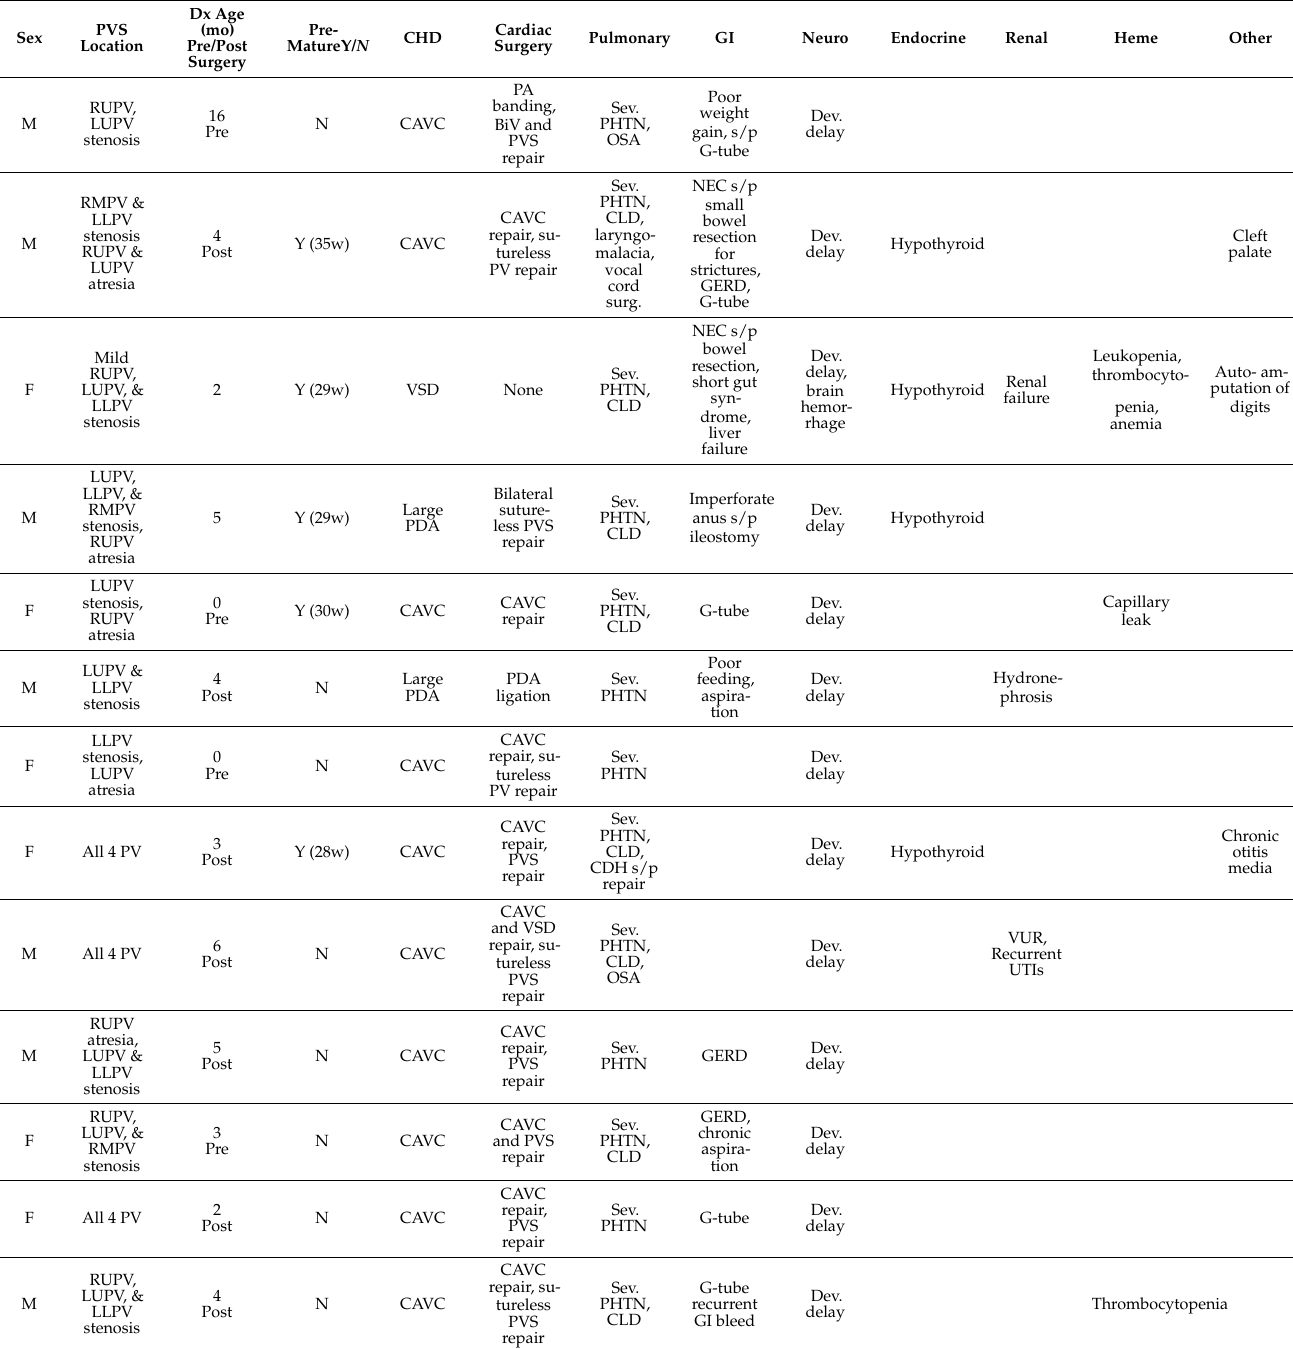
Table 2. Clinical phenotyping of PVS patients with Trisomy 21 ( n =